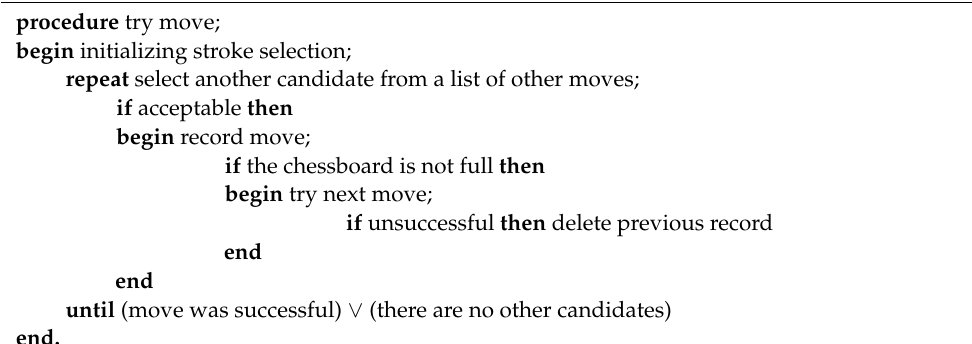
Algorithm 1 : Algorithm to determine the possibility of making the next move procedure try